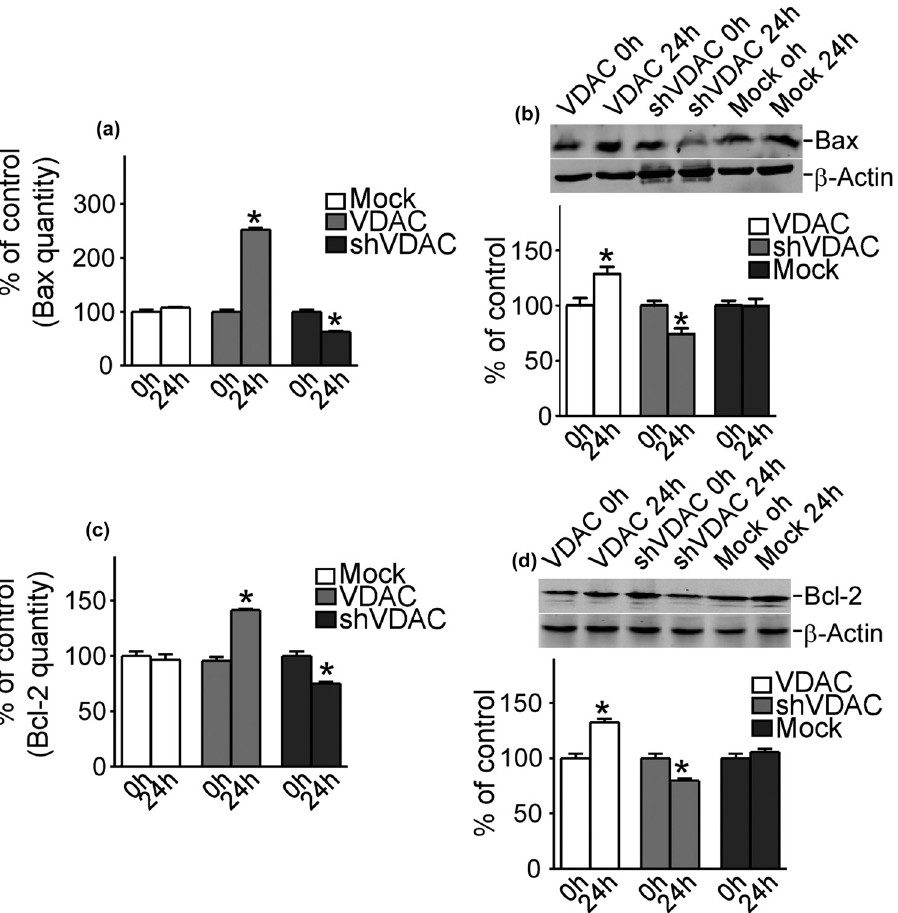
Figure 3: VDAC1 increased the expression of Bax and Bcl - 2. ( a and b ) The mRNA and protein levels of Bax with upregulation of VDAC1. ( c and d ) The mRNA and protein levels of Bcl - 2 with upregulation of VDAC1. Values represent means ± SD, n = 3. P < 0.05 by Student ’ s t -